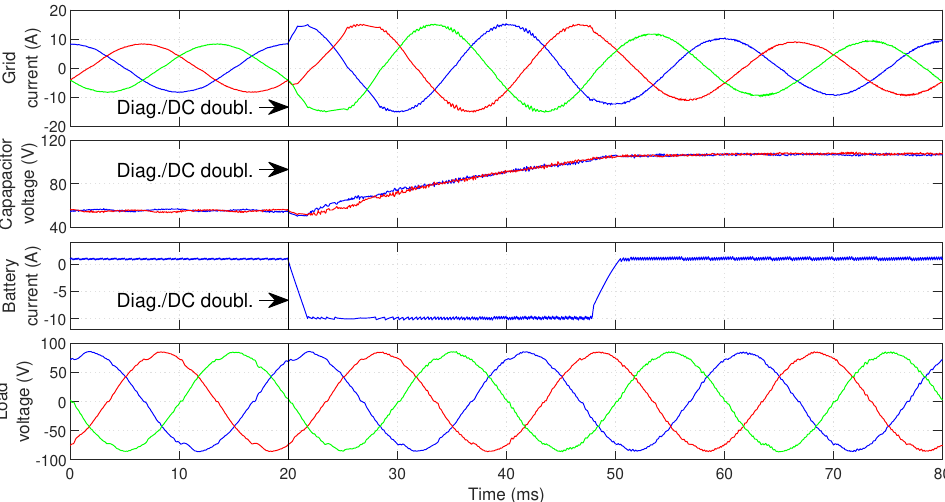
Figure 24. Normal and fault-tolerant UPS operation when an OC occurs in outer IGBT S D 1 of the DCC.